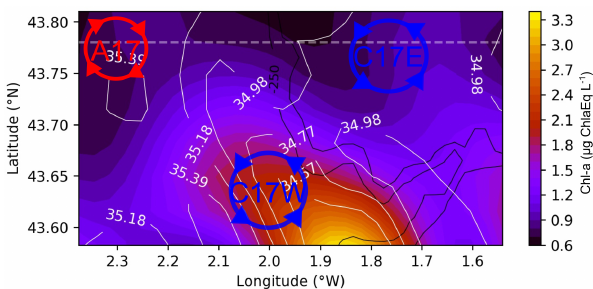
Figure 6. Surface chl a at 3.5m from the surface Fluoroprobe for the period (2 to 4 August 2017). White contours represent the salin- ity field, while black contours represent the 200 and 250m isobaths. The red (blue) circles in the left column represent the approximate location of A17 (C17W and